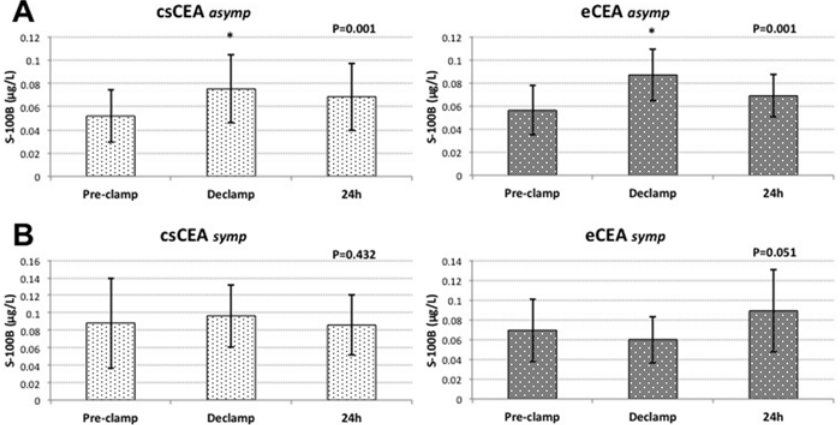
Fig 5. Variations of protein S-100B serum concentrations in relation to the symptomatology of carotid disease. (A) asymptomatic patients; (B) symptomatic patients; * — significant compared to pre-clamp (P <